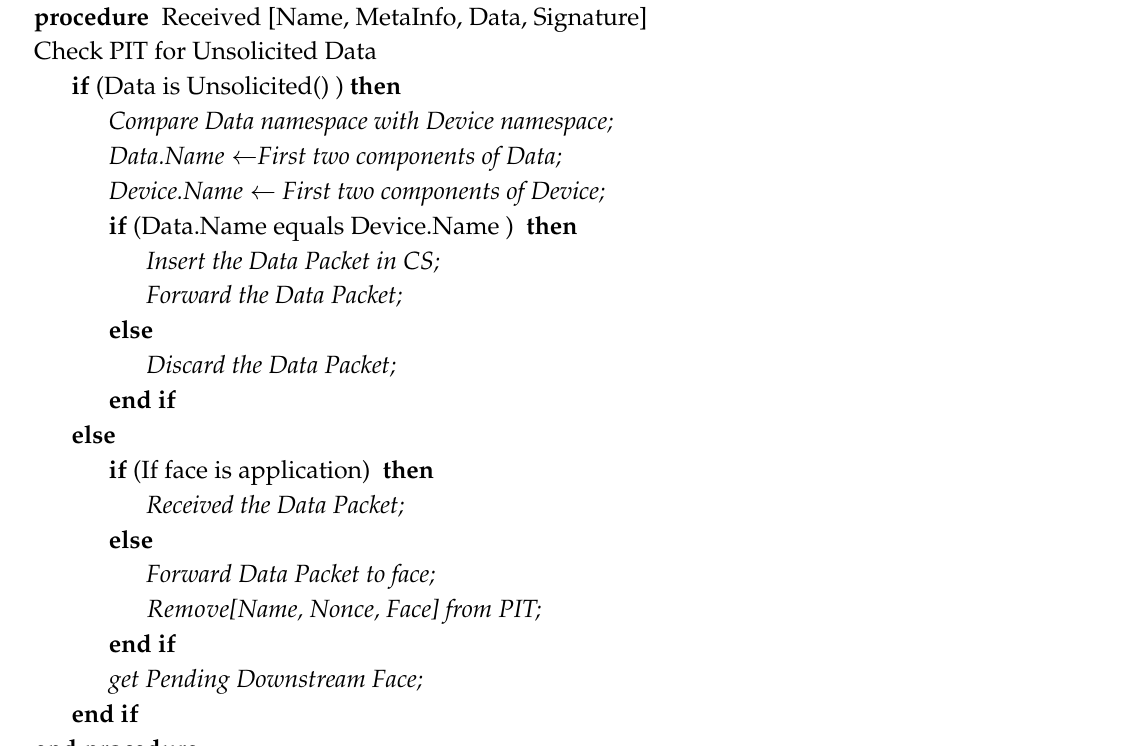
Algorithm 1 Received data packet in the Proposed Push-based Scheme for Building